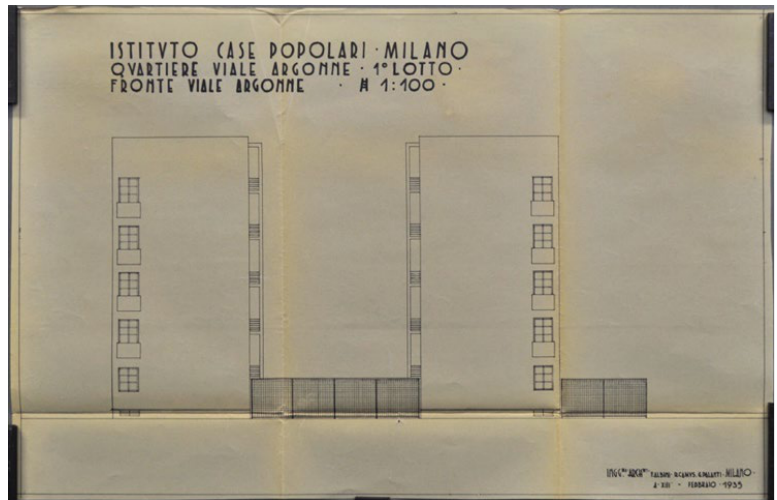
Figure 12 Elevation. By Franco Albini, Renato Camus and Giancarlo Palanti. 1935. (Archivio Fondazione Franco Albini,